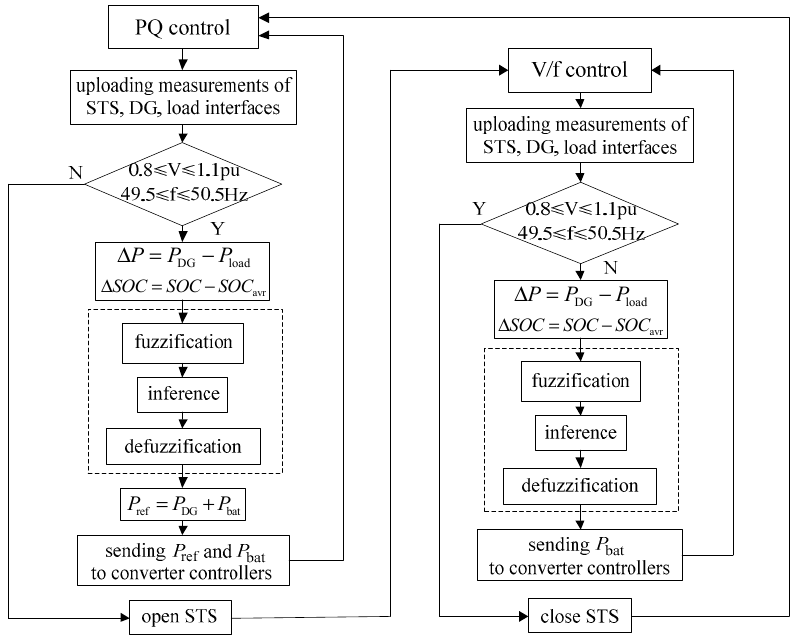
Figure 8. Flow chart of power management.